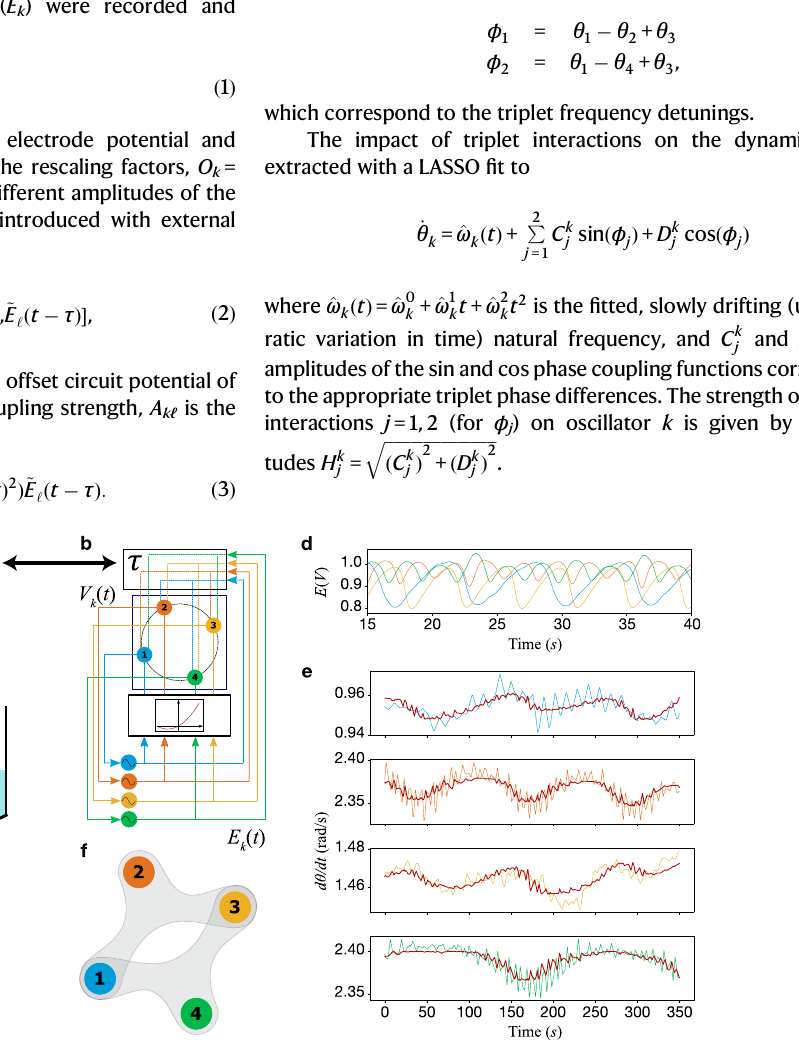
Fig. 1 | Emergent hypernetworks in an electrochemical network experiment. a Experimental setup. b Schematic illustration of the electrochemical experiment withthenonlinearfeedback.Theblue,orange,yellow,andgreenlinesrepresentthe elements1to4,respectively.Theelectrodepotentialsignals( E k )ofthefour(nearly) isolated electrodes are nonlinearly modulated and fed back with a delay τ to the correspondingcircuitpotential( V k ),whichdrivesthemetaldissolution.(Thedelay